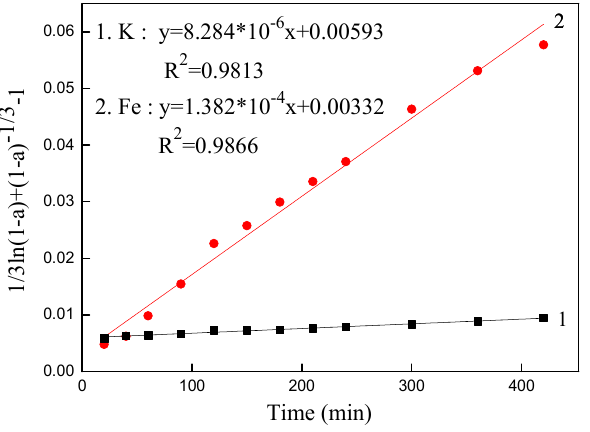
Figure 12. The diffusion kinetics model during removing process: 1/3ln(1 − α) + (1 − α) −1/3 − 1 versus reaction time.